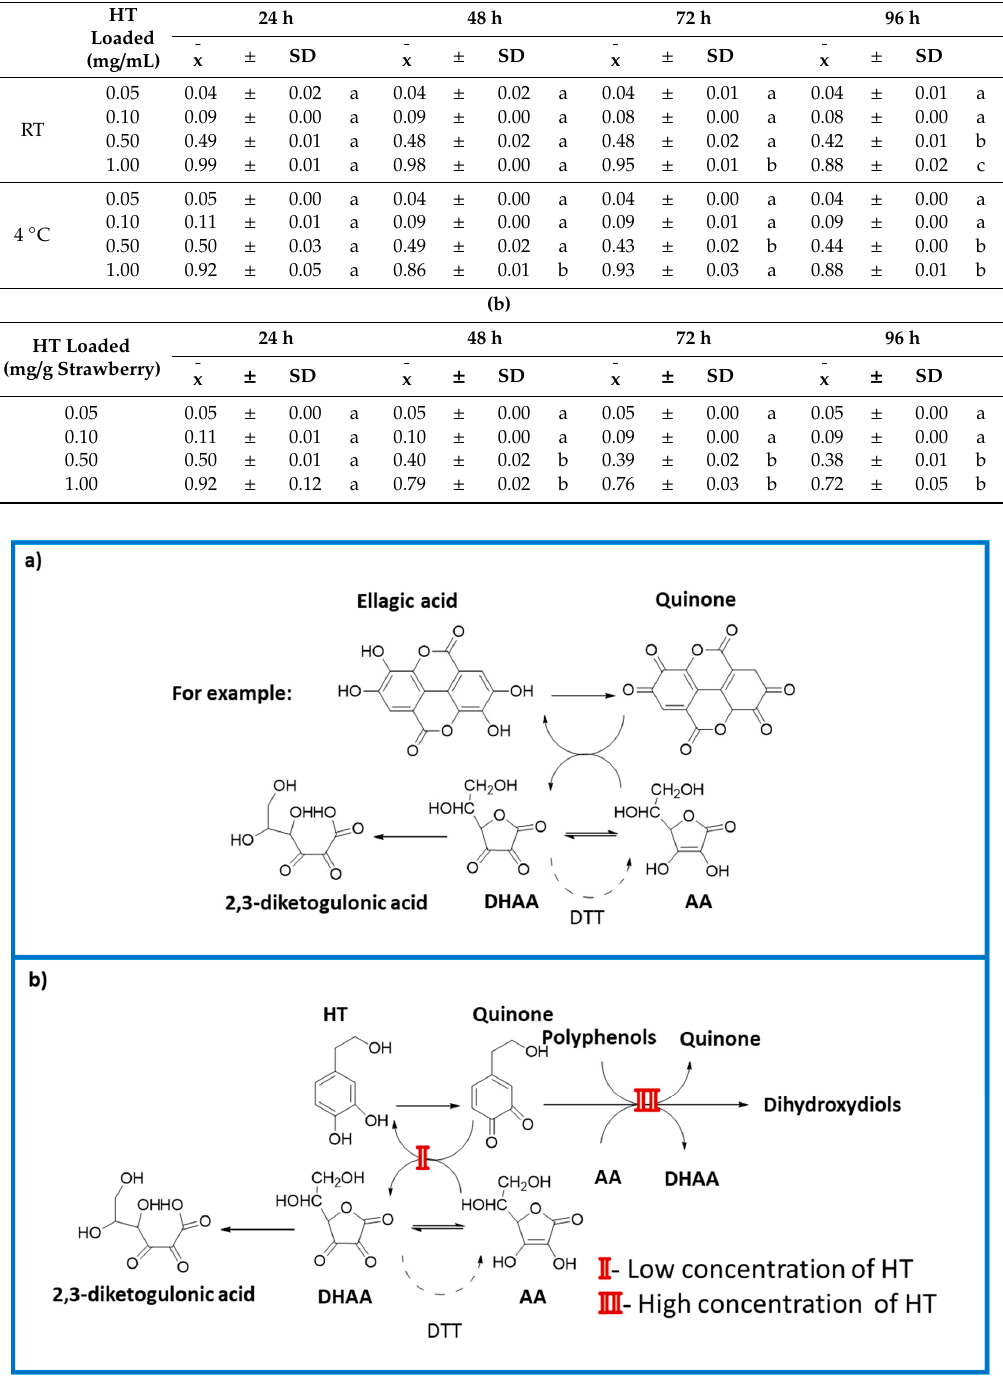
Figure 3. Summary scheme of the changes that take place in vitamin C in strawberry puree stored at 4 °C, without added HT ( a ), and in the presence of HT ( b